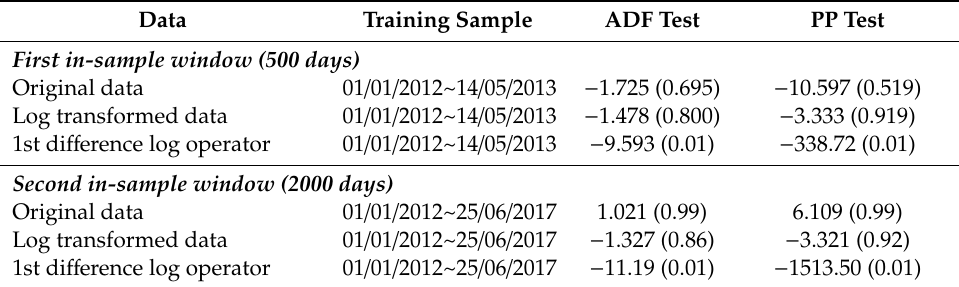
Table 1. Stationary test of